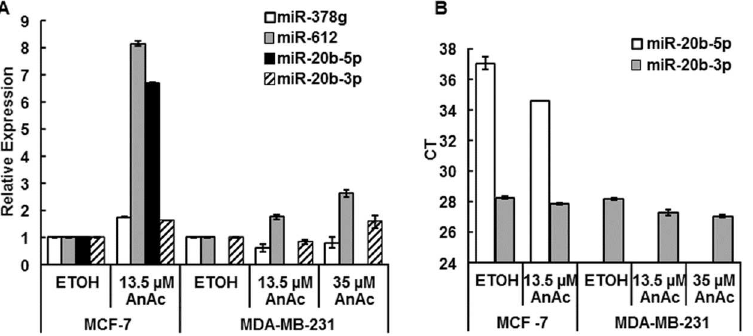
Fig 3. qPCR analysis of select AnAc-regulated miRNA expression. MCF-7 and MDA-MB-231 cells were grown in hormone-depleted medium for 48 h prior to 6 h treatment with 13.5 or 35 μ M AnAc. A. qPCR using TaqMan assays for miR-378g,miR-612, miR-20b-5p, and miR-20b-3p was performed using U48 as normalizer. B. CT values for miR-20b-5p and miR-20b-3p expression. miR-20b-5p was not detected in MDA-MB-231 (CT values ‘undetermined). For both A and B: Values are the mean ± SEM of triplicates in one experiment for MCF-7 cells and are the mean ± SEM of two independent experiments for MDA-MB-231 cells.